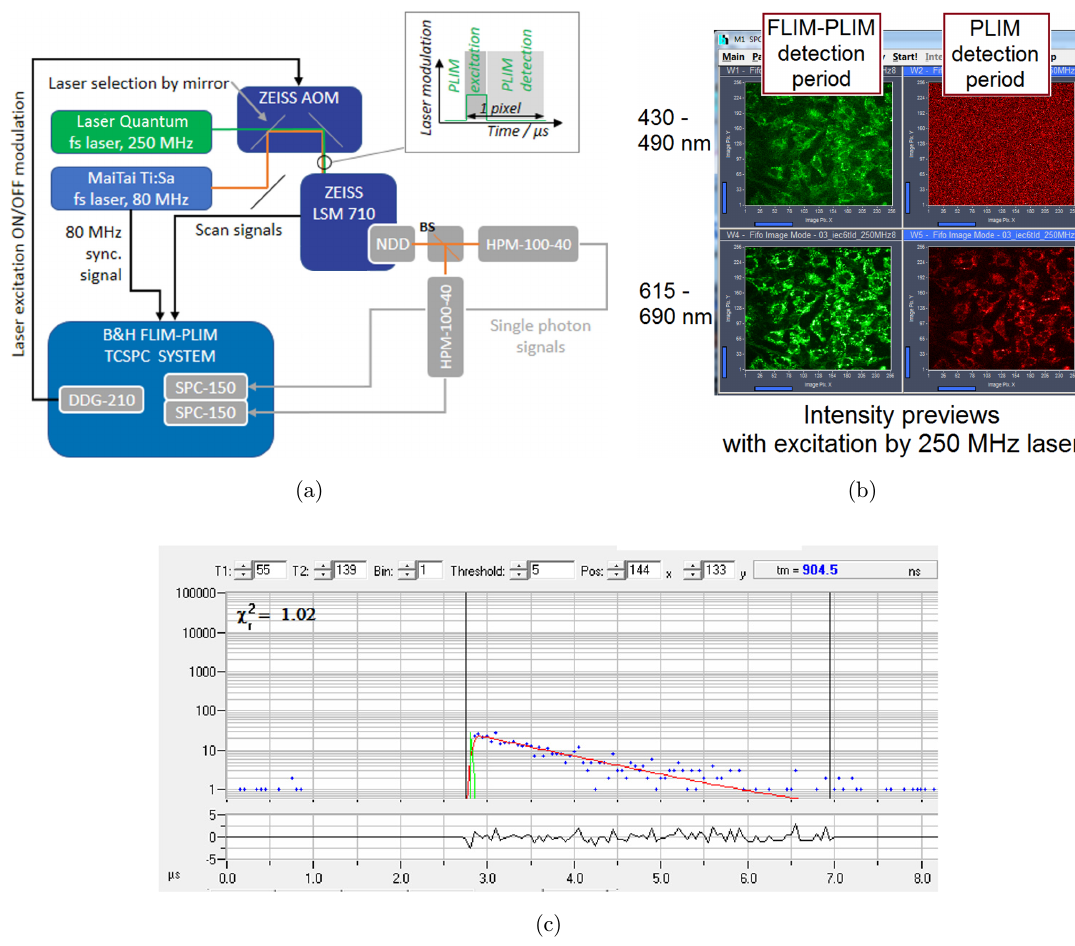
Fig. 2. Schematic of the two-photon FLIM – PLIM setup employing either an 80 MHz or 250 MHz fs laser, Zeiss LSM 710 with AOM, fast single photon counting HPM-100-40 detectors and FLIM – PLIM TCSPC system. In this mode, the 80 MHz laser only provides the synchronization signal. (b) Intensity preview images during measurement with the 250 MHz laser. Left and right: photons collected during the PLIM excitation and detection period, respectively. Spectral detection was done in the range from 430 nm to 490 nm (upper row) and 615 nm to 690 nm (lower row). Images show TLD1433-stained monolayered IEC-6 cells. (c) A phosphorescence decay curve in a single pixel of a PLIM-image of the 615 – 690 nm spectral